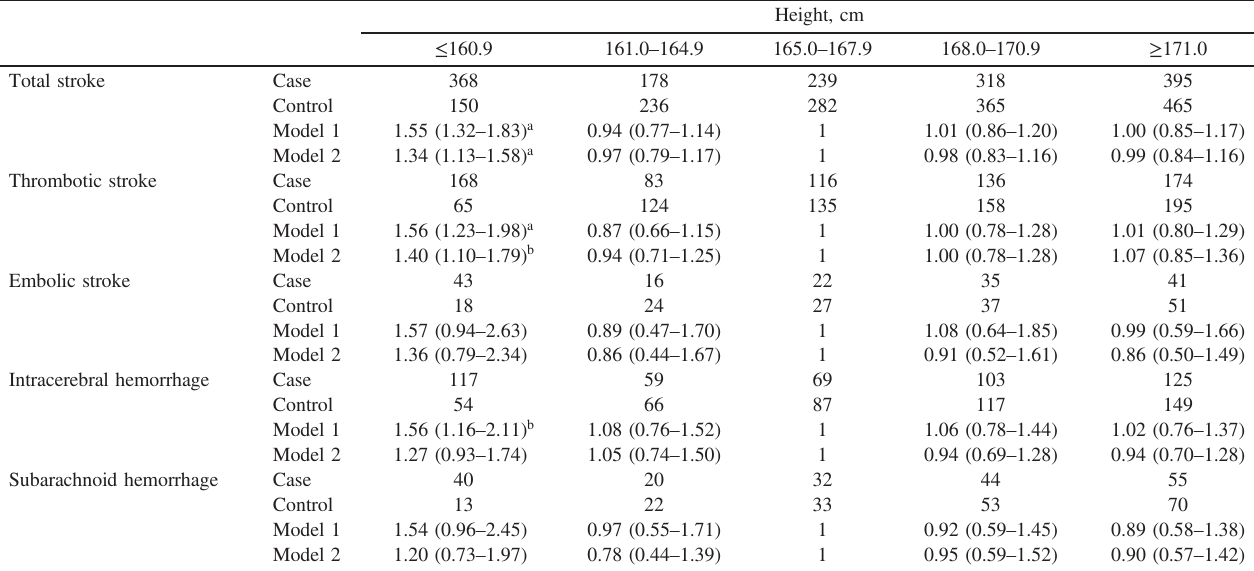
Table 3A. Multivariable-adjusted odds ratios and 95% con fi dence intervals of stroke and its subtypes according to height in men aged 40 – 59 years, Aichi, Japan